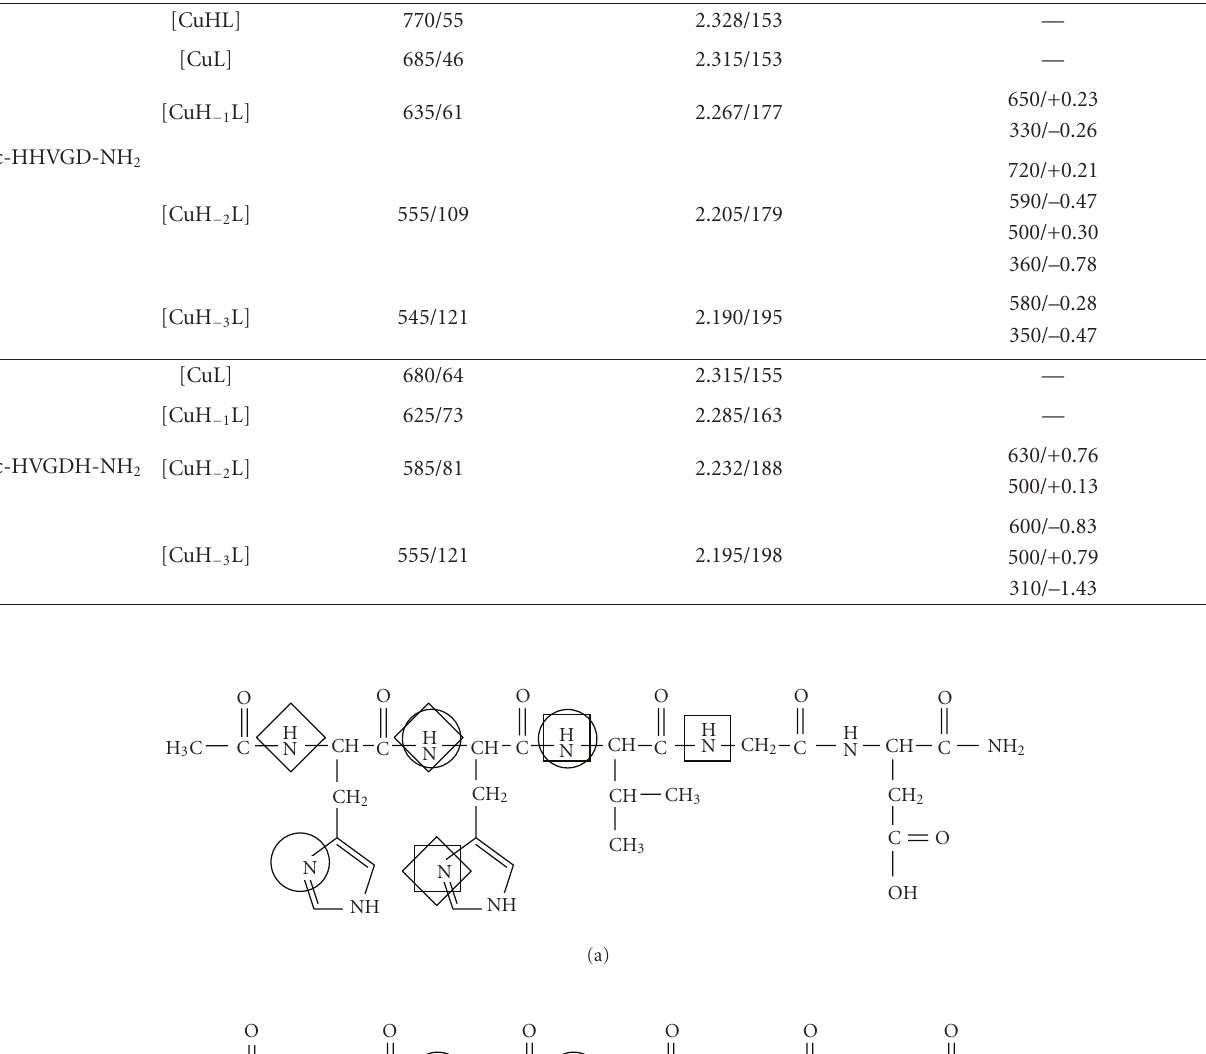
Table 3: Spectroscopic parameters of the major species formed in the copper(II)-Ac-HHVGD-NH 2 and Ac-HVGDH-NH 2 systems.